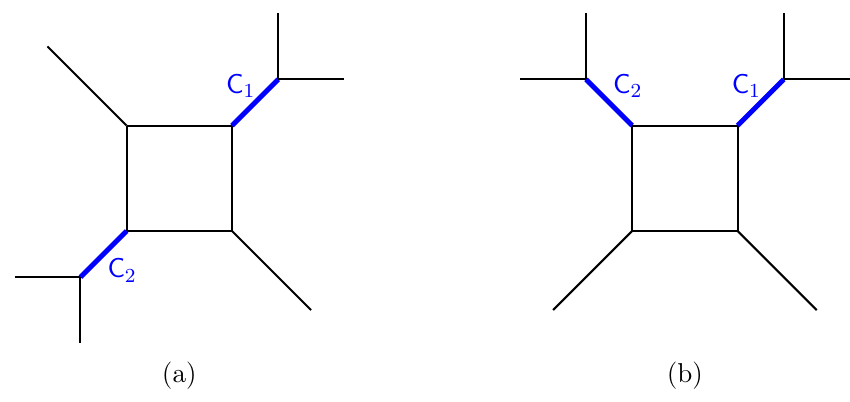
Figure 5 . Brane diagrams for SU(2) gauge theory with two flavors, by inserting curves C 1 , 2 in different